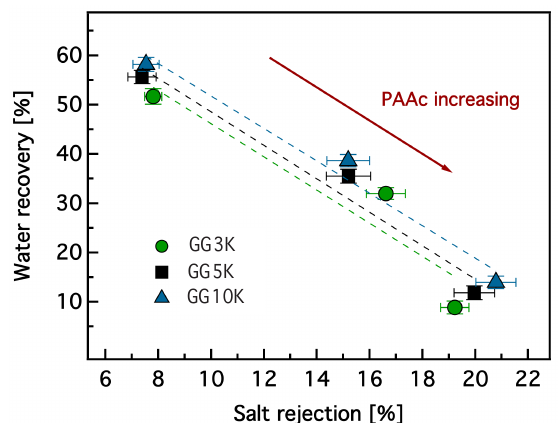
Figure 14. The competition between hydrophilic and hydrophobic balance on the performance of hydrogels in the proposed desalination process. The salt rejection increases as the water recovery decreases. Gel samples in powder form were swollen in excess salt solution of 2 gL − 1 NaCl from the dry state and shrunk throughout 60 min at 50 ◦ C. The straight lines are linear fits to the data.